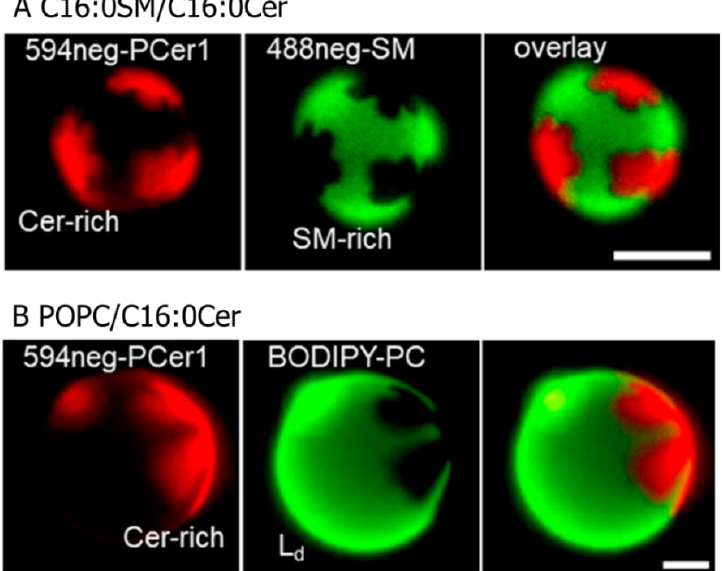
Figure 2. Fluorescence micrographs of binary-component giant unilamellar vesicles (GUVs) that underwent phase separation between the ceramide-rich and ceramide-poor (thus, phospholipid- rich) domains. ( A ) C16:0SM/C16:0Cer (95:5, molar ratio) GUVs containing 0.2 mol % 594neg-PCer1 (ceramide-rich domain marker) and 0.2 mol % 488neg-SM (SM-rich domain marker). ( B ) Palmitoyl- oleoyl–phosphatidycholine (POPC)/C16:0Cer (95:5, mole ratio) GUVs containing 0.2 mol % 594neg- PCer1 and BODIPY-PC (POPC-rich fluid phase marker). Bars indicate 10 μm. Image brightness and contrast were adjusted for clarity. This figure was adapted with permission from [41] . Copyright 2019 American Chemical Society.